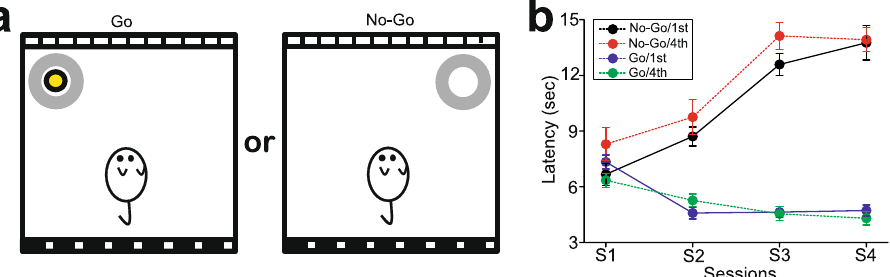
Figure 3. Spatial Go/No-go test in mice at higher and lower social ranks. ( a ) Schematic diagrams illustrating Go (a bowl with a food reward) and No-go (a bowl only) trials of the spatial Go/No-Go test. Spatial cues